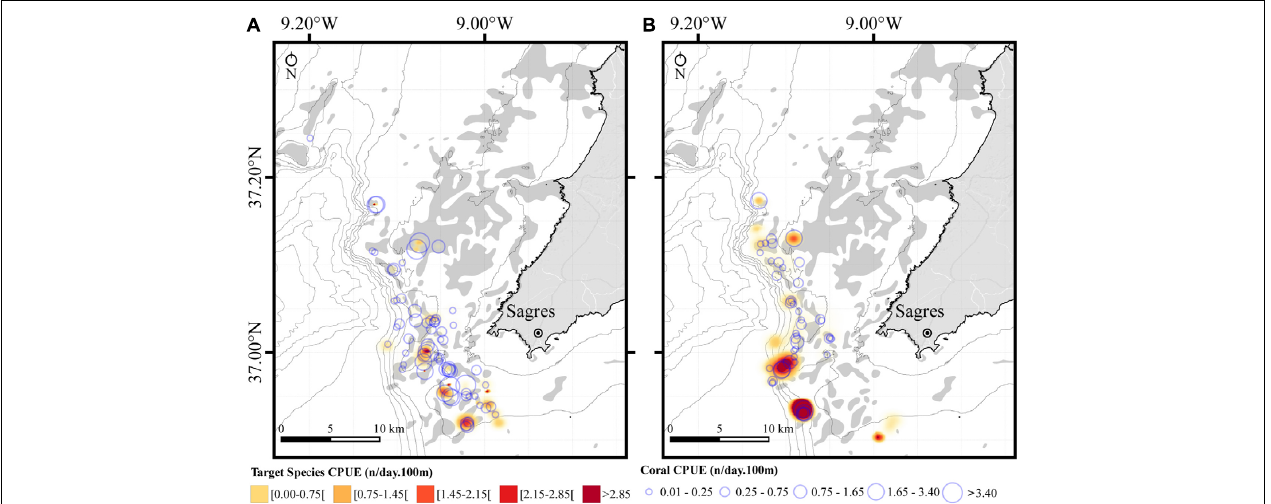
FIGURE 4 | Spatial distribution of the total fishing effort for target species and coral bycatch in bottom-set gillnets off the coast of Sagres (southern Portugal). Fishing effort was calculated as the catch per unit effort (CPUE) and represents the number of specimens (fish/lobster or coral) as a function of the product of the net soaking time (days) and 100 m of net length deployed. (A) Summer-autumn sampling season (1 September to 16 October 2019). (B) Spring sampling season (11 May to 5 June 2020). CPUEs for the target species are displayed as heatmaps generated using triweight kernel density and corals displayed as bubbles. Bathymetric isobaths are as follows: 50 m, 100–500 m (increments of 100 m), and > 500 m (increment of 200 m). Rocky substrate is represented as gray